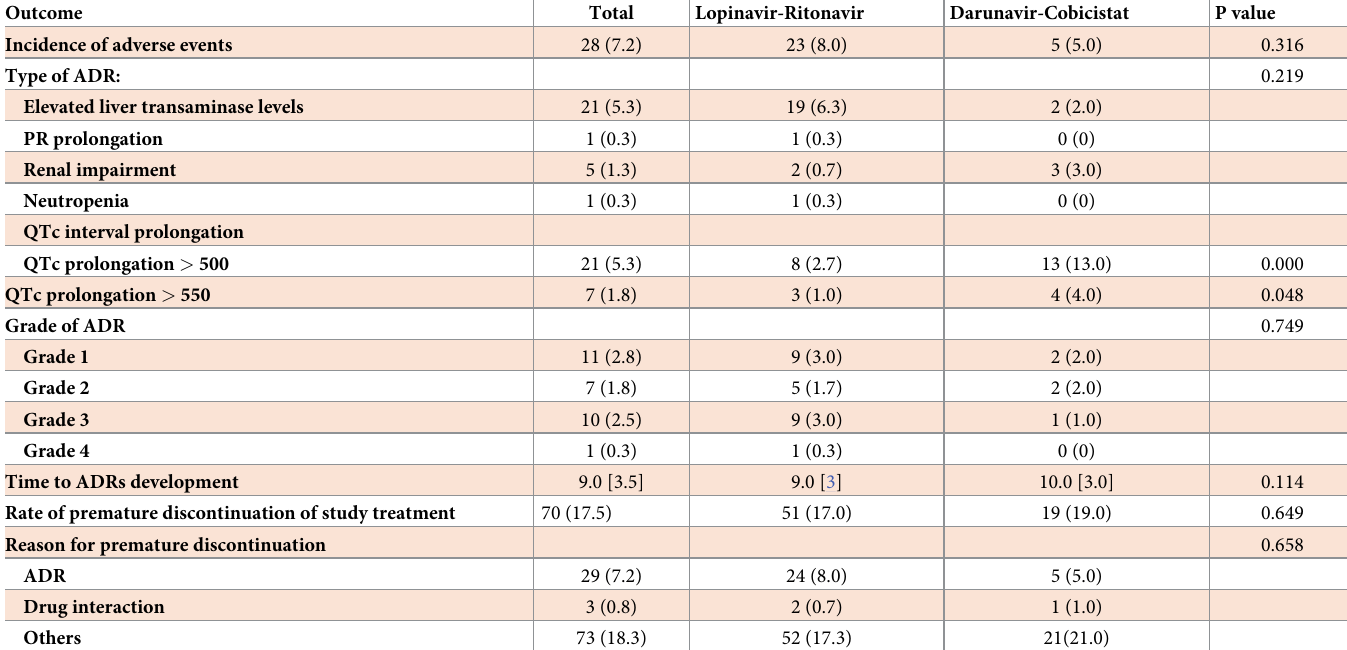
Table 4. Safety outcomes of the study